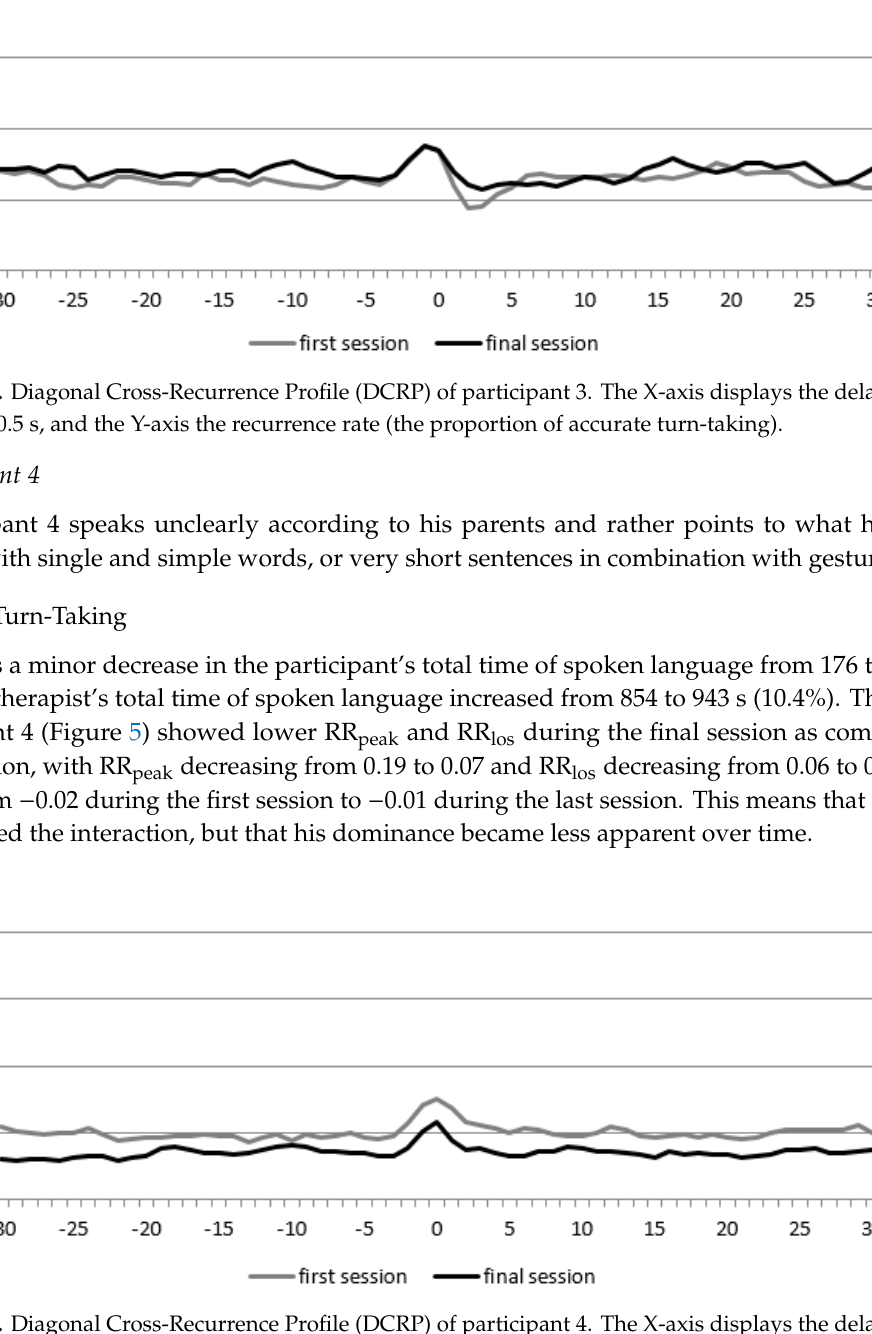
8 of 15 Figure 3. Diagonal Cross-Recurrence Profile (DCRP) of participant 2. The X-axis displays the delay in steps of 0.5 s, and the Y-axis the recurrence rate (the proportion of accurate turn-taking). 3.3. Participant 3 According to his parents, participant 3 is able to speak, but it is hard for him to communicate with the right words. He has weak mouth motor skills, which results in difficulty to formulate sounds with his mouth and slow speech. He uses single words and sometimes 3–4-word sentences, with regular echolalia. He is quickly over-stimulated and is only able to communicate with supportive gestures. His parents often let him finish sentences, such as: “We go to” “the dolphins”. Analysis of Turn-Taking This participant’s total time of spoken language increased from 113.5 to 126 s (11.0%). Additionally, for the therapist, this increased from 562.5 to 605.5 s (7.6%). As Figure 4 shows, the